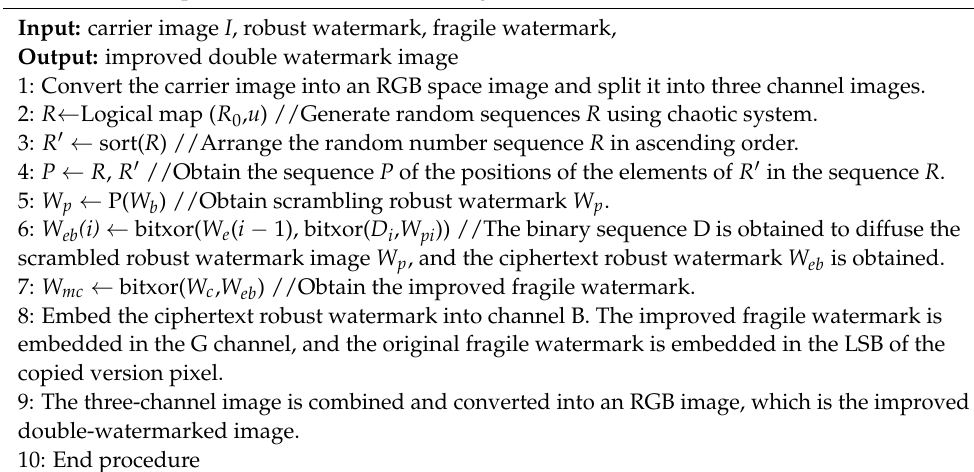
Algorithm 7: Improved Double Watermark